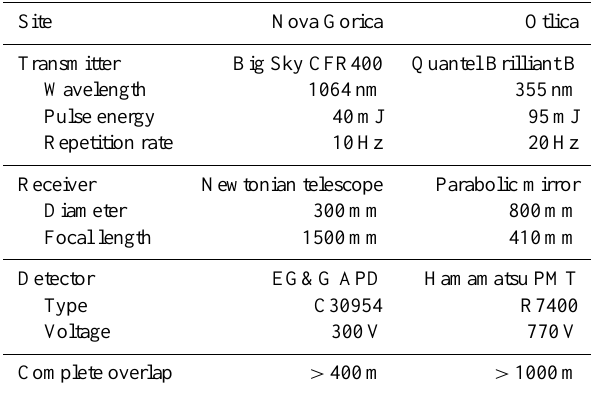
Fig. 3. Results of the composition analysis of precipitation in Ljubljana between 10 April and 3 May 2010, showing concentrations (left) and depositions (right) of various anions (Cl − , NO − , SO 2 − and F − ) in the precipitation.